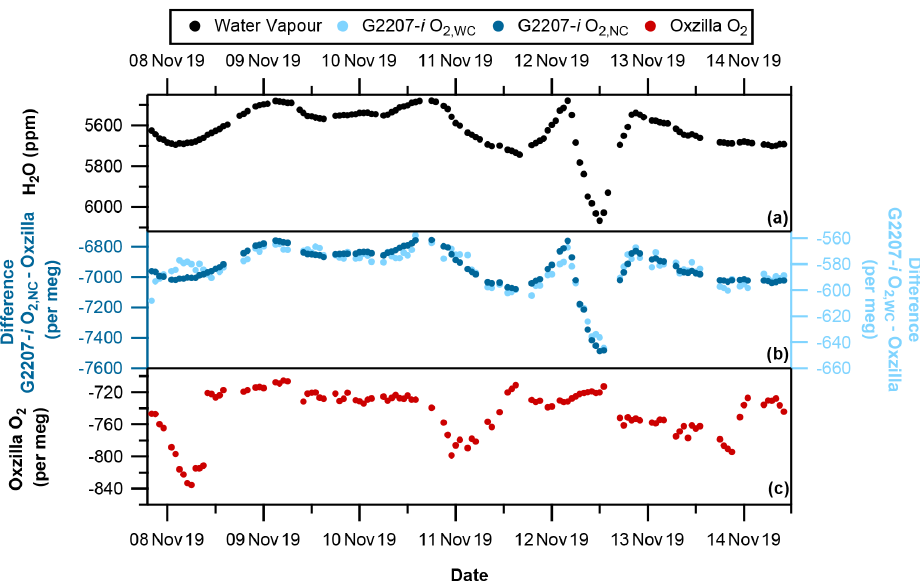
Figure 5. With partial drying of the sample air through the G2207- i (a) Hourly averaged water vapour, (b) G2207- i –Oxzilla difference for O 2 , NC (dark blue) and O 2 , WC (light blue), and (c) Oxzilla O 2 (Oxzilla sample air is fully dried). Note the reversed water vapour axis and different axis scales for O 2 , NC and O 2 , WC . The spike in water vapour on 12 November 2019 is due to a temporary increase in the temperature of the